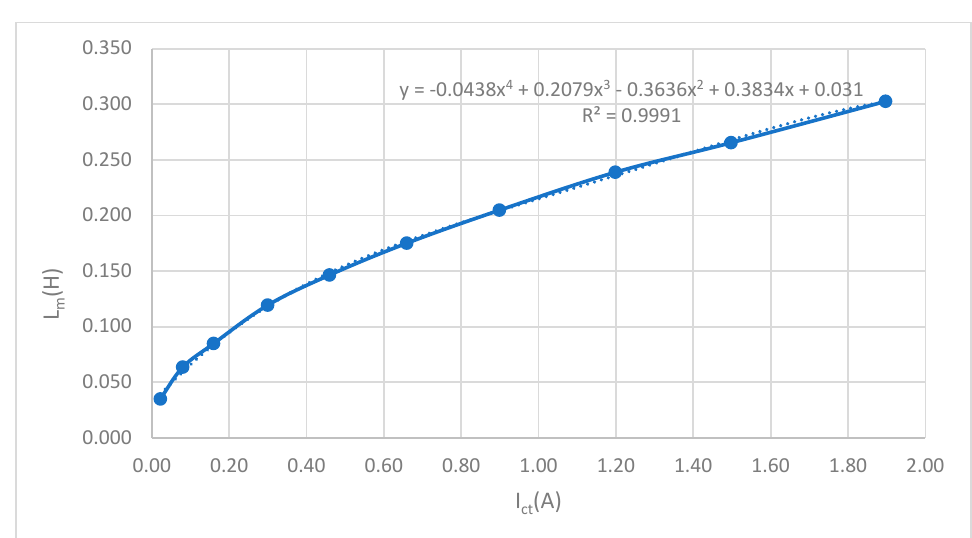
Figure 5. Dependance of the inductance L m on the secondary current of CT. Table 3. Factory data of the saturation magnetic curve. Table 2. Results of factory test of current